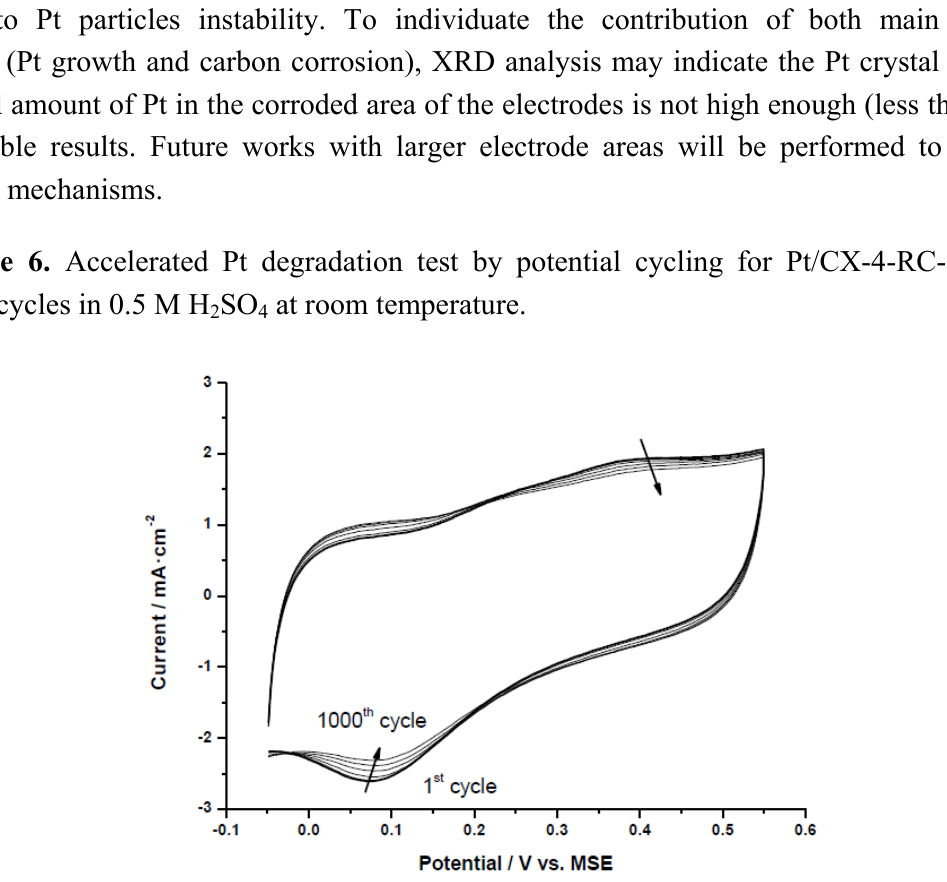
Figure 7. Cyclic voltammetry (half-cell, nitrogen fed, 0.5 M H